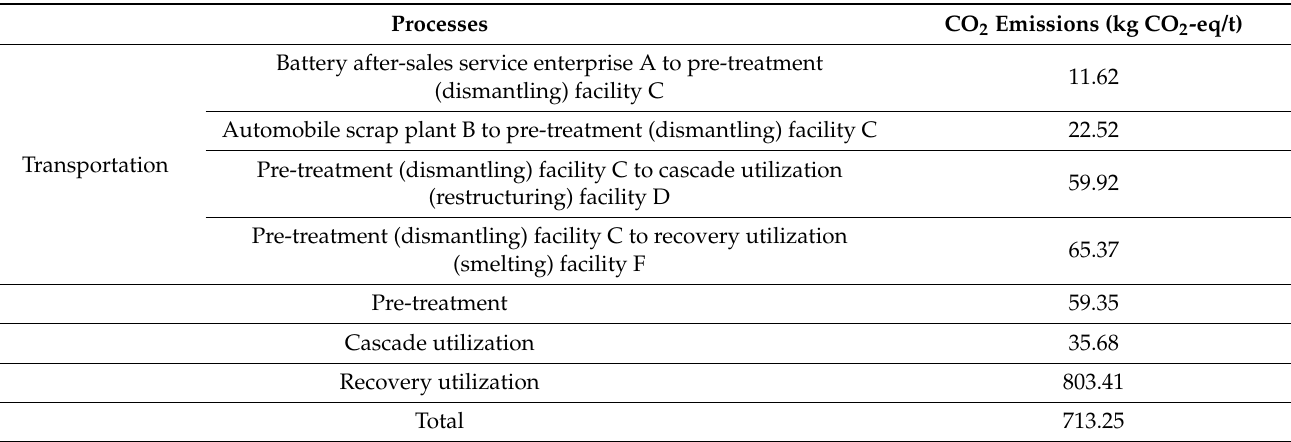
Table 8. GHG emissions from the recycling process for waste